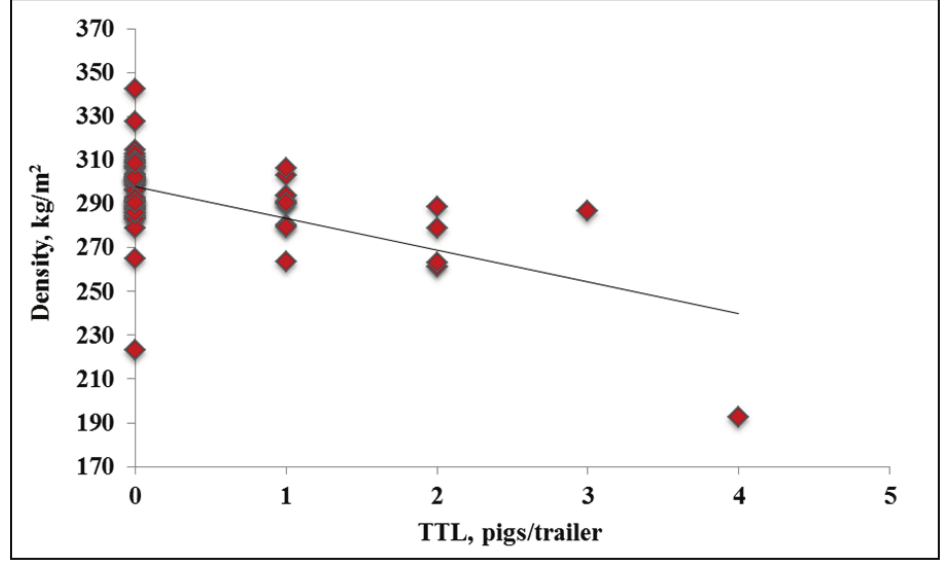
Figure 6. Experiment 2. Effects of density on trailers on total transport losses pigs per trailer in market weight pigs at unloading in HOT weather ((cid:2)26.7 °C; p < 0.01, R 2 =